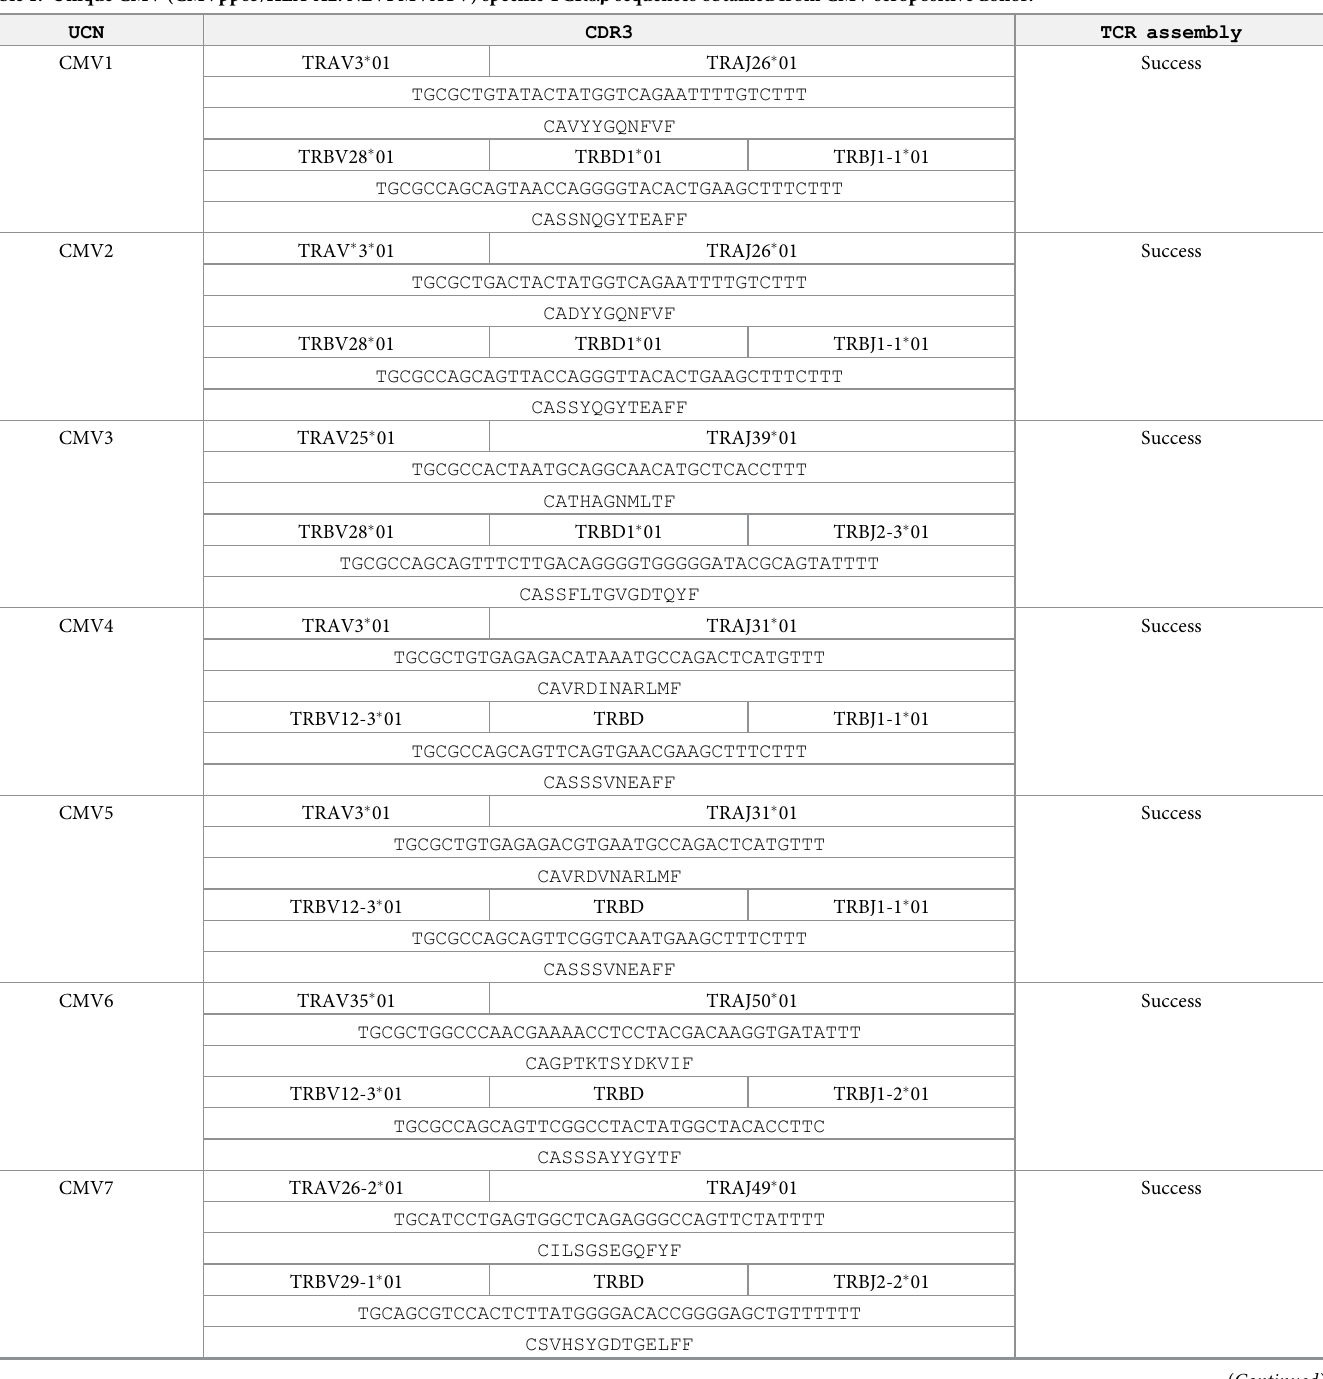
Table 1. Unique CMV (CMVpp65/HLA-A2: NLVPMVATV) specific TCR αβ sequences obtained from CMV seropositive